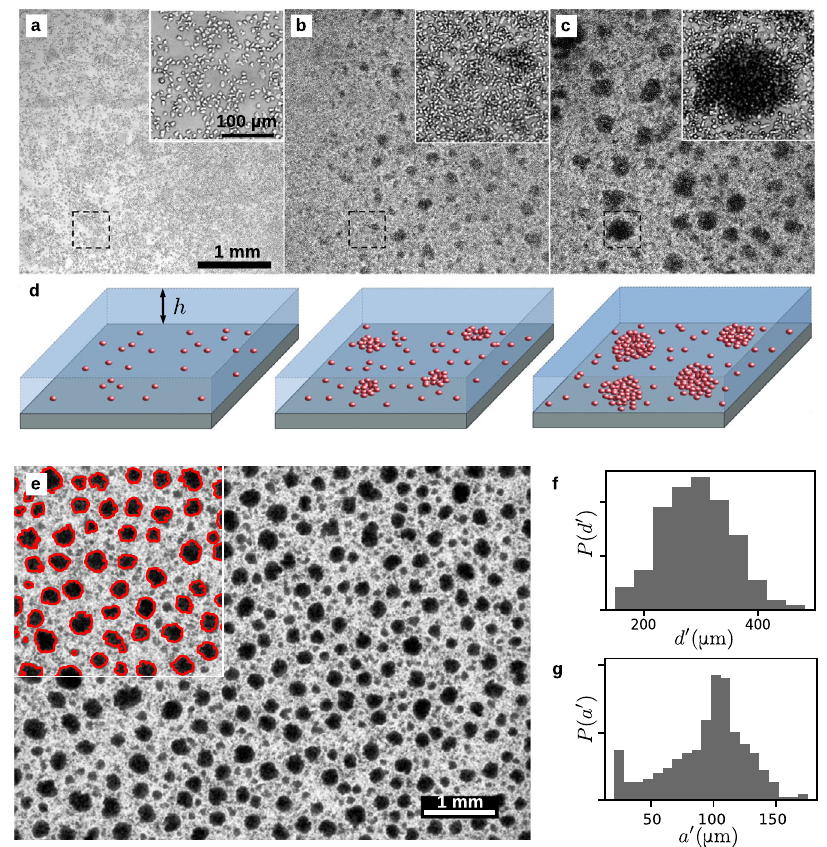
Fig.1|Microphaseseparationinapopulationof Dictyosteliumdiscoideum cells. a – c Bright fi eldimagesofthegrowthandaggregationprocessinthecourseoftime. Eachinsetis a close-up of the dashed box. The liquid fi lm height is h =1.5mm. This experiment was repeated independently dozens of times with similar results. a t =24h: the cell population has grown but remains rather homogeneous. b t =48h: while still dividing, cells gather in small growing aggregates. c t =110h: